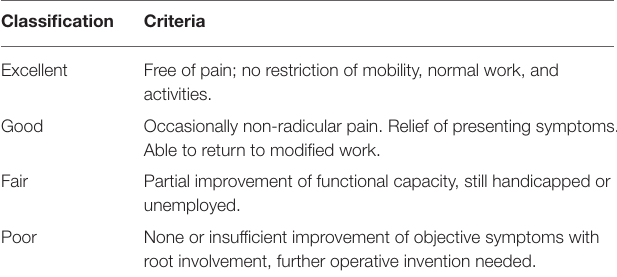
TABLE 1 | Clinical outcome assessed by the modified Macnab Criteria.